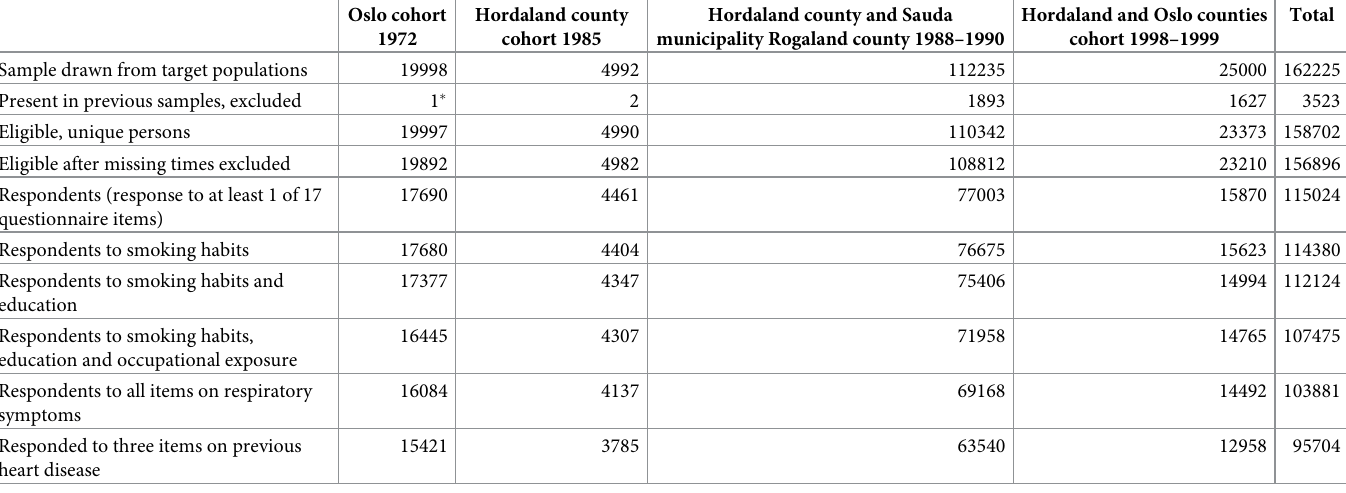
Table 1. Flowchart of randomly sampled individuals in the study of respiratory symptoms and cardiovascular deaths in